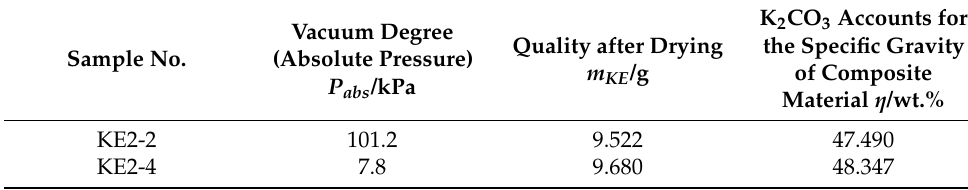
Table 3. KE2 series of major operations and sample data.